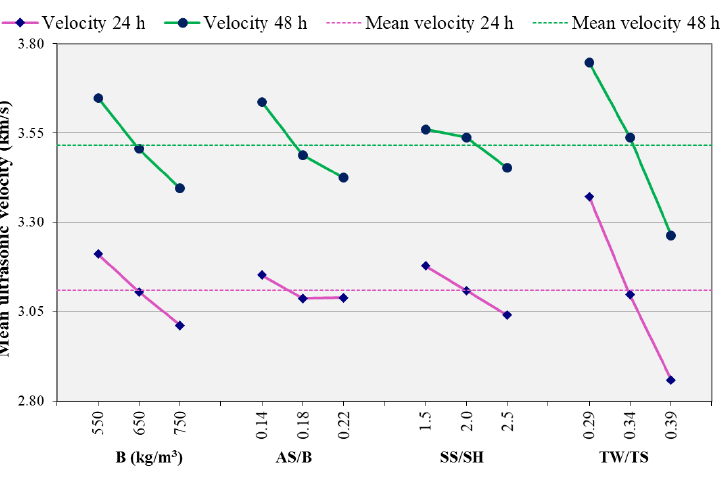
Figure 8. Effect of parameters on ultrasonic velocity.